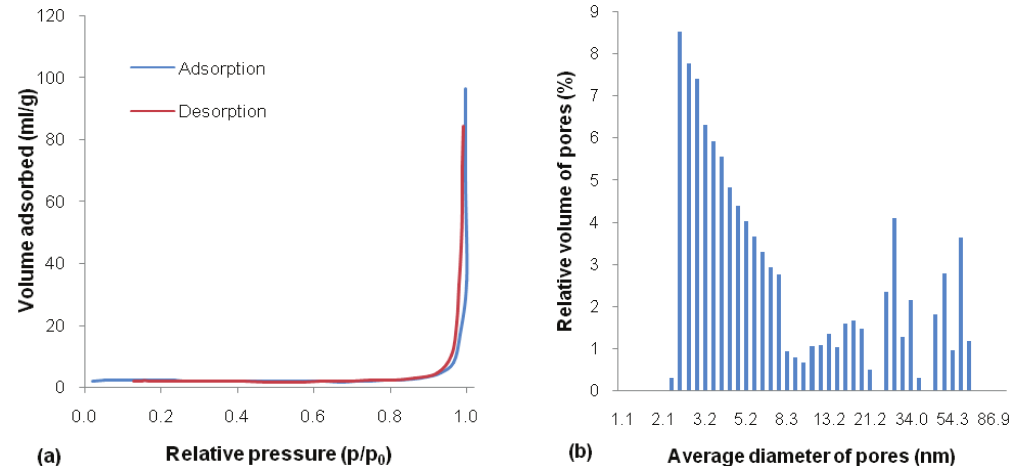
Figure 2. (a) Nitrogen adsorption/desorption isotherms at 77 K; (b) Pore size distribution of H